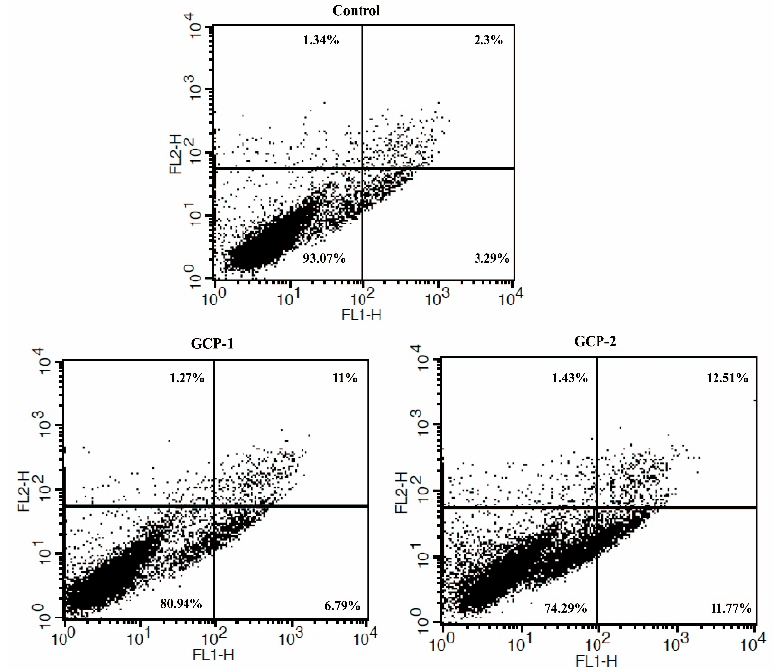
Figure 5. Flow cytometric analysis of apoptosis after treatment with GCP-1 and GCP-2 in human lung carcinoma A549 cell lines using Annexin V-FITC/PI.